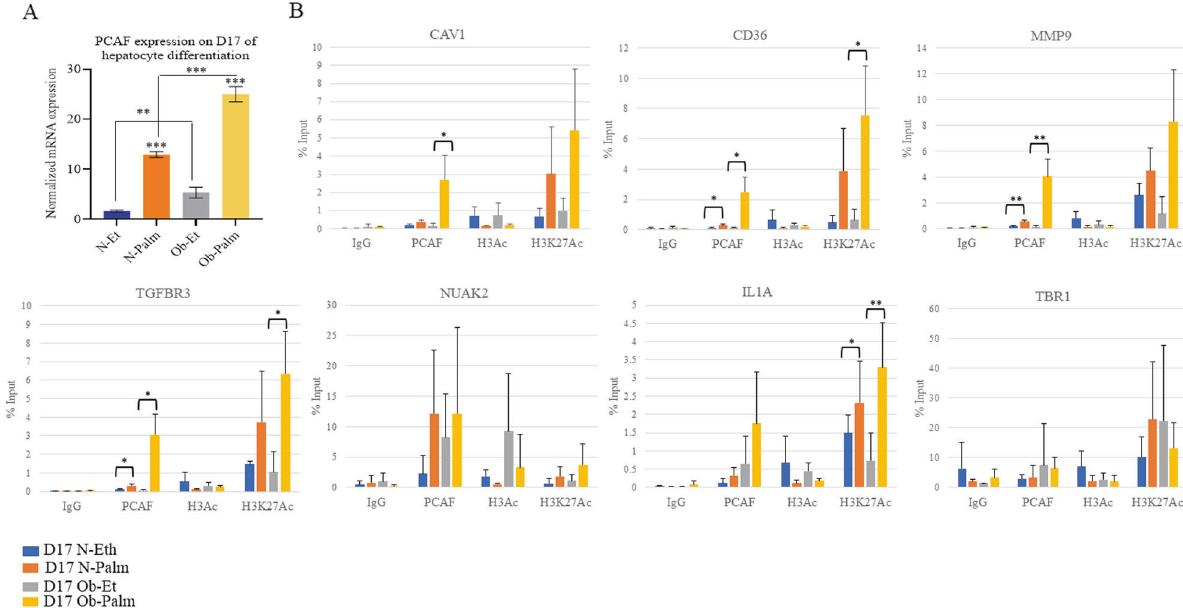
Fig. 6 Effect of palmitate treatment and obese genotype on PCAF expression and histone acetylation. A mRNA expression analysis of PCAF gene by RT-qPCR in normal (N) and obese (Ob) iPSCs treated with solvent control (Ethanol) and 100 μ M palmitate (Palm) at day 17 of hepatocyte differentiation using gene-speci fi c primers. The expression of the β -ACTIN gene was used to normalize the expression. The data are represented as mean ± standard deviation. ** p ≤ 0.01, *** p ≤ 0.001 (two-tailed unpaired Student ’ s t test). The data are representative of three independent biological replicates. B Normal and obese iPSCs-derived hepatocytes (D17) were used to perform ChIP assay for PCAF, H3Ac, and H3K27Ac using ChIP grade antibodies. ChIP with IgG was used as the negative control. ChIP ’ d DNA was analyzed by real-time qPCR for the promoter regions of CAV1, CD36, MMP9, TGFBR3, NUAK2, IL1A, and TBR1 genes. Data represent the mean of three biological replicates ± SD. Statistical analyses (unpaired student ’ s t test) were made between control (Et) and palmitate (Palm) treated samples using GraphPad Prism Software. Asterisks represent differences being signi fi cant 1098 (* p < 0.05, ** p < 0.01, *** p <